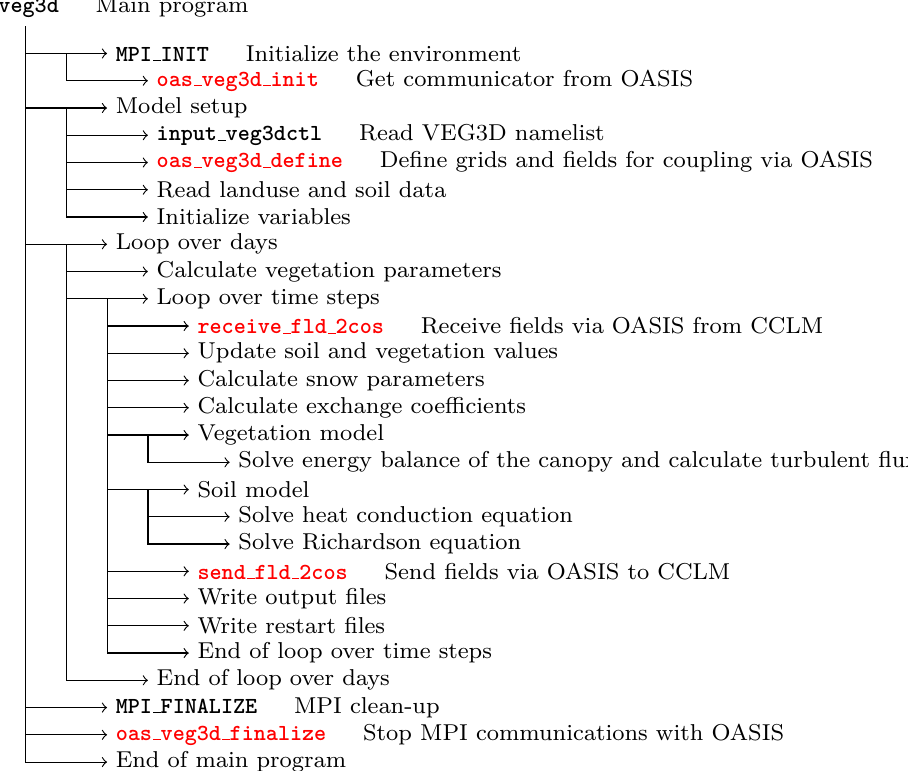
Figure 12. As Fig. 8 but for the VEG3D soil–vegetation model.